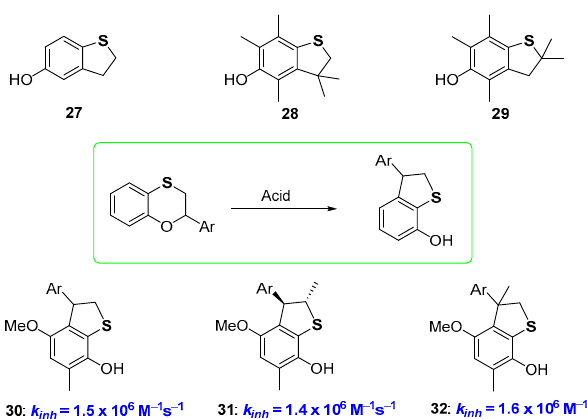
Figure 9. Hydroxy-2,3-dyhydrobenzo[ b ]thiophene antioxidants.